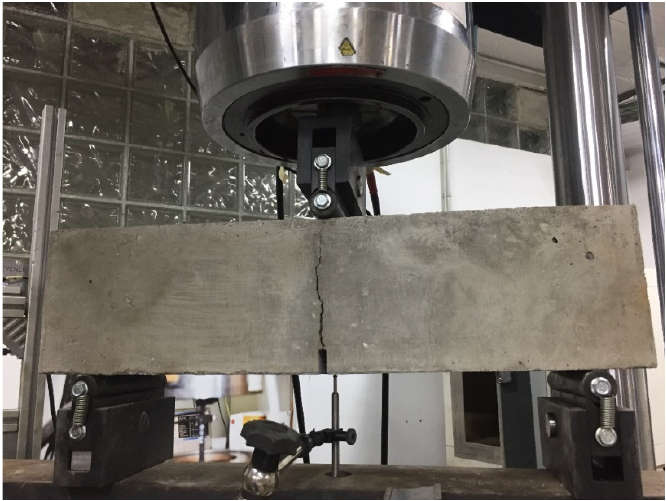
Figure 3. Flexural tensile strength test of the fibre-reinforced